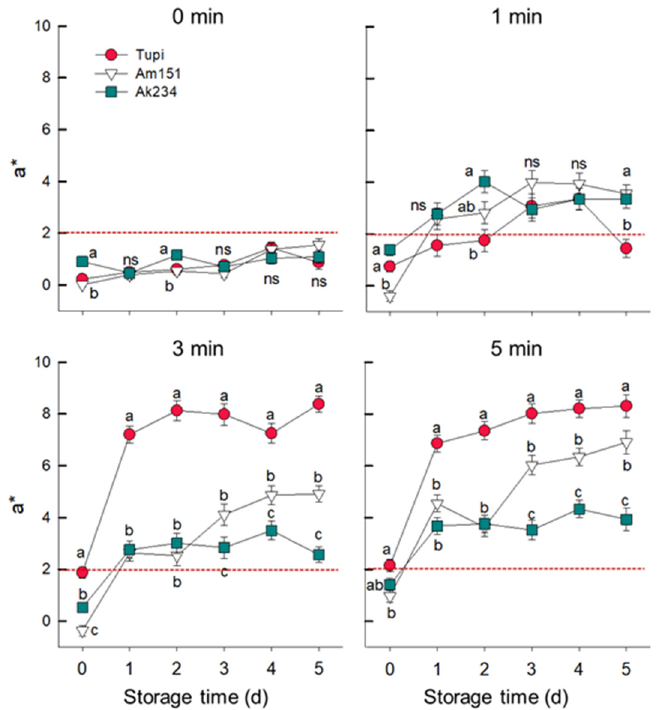
Figure 5. Portable vibrator system could be used as a tool to evaluate color progression in different blackberry fruit. Bottom graph depicts mean value ± SE of a* color CIELAB parameter in ‘Ak234 ′ , ‘Am151 ′ and ‘Tupi’ cultivars induced by different vibration (10 Hz and 0.5 g’ s) times (0, 1, 3 and 5 min) during 5 d of storage at 1 °C ( n = 15). Red line specifies limit between blackish (a* ≤ 2.0) and reddish (a* > 2.0) color. Different letters indicate statistical differences ( p < 0.05) using one-way ANOVA and Tukey test.